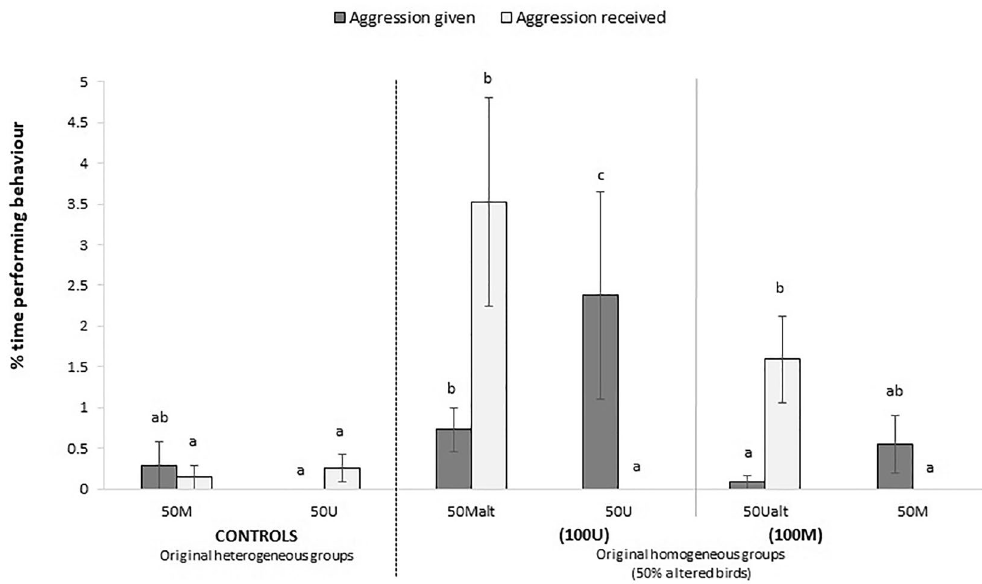
Figure 2. Effects of phenotype alteration to 50% of individuals on the behaviour of hens at 39–40 weeks of age (t2). M: marked; U: unmarked; alt: altered. Bars represent means ± standard errors. Different letters within the same behaviour indicate significant differences among groups at p < 0.05.